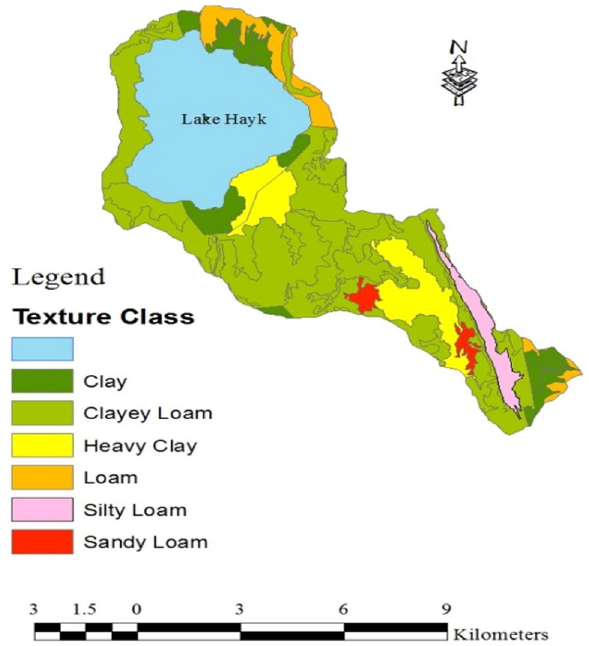
Fig. 4 Soil texture classes in Hayk Lake basin